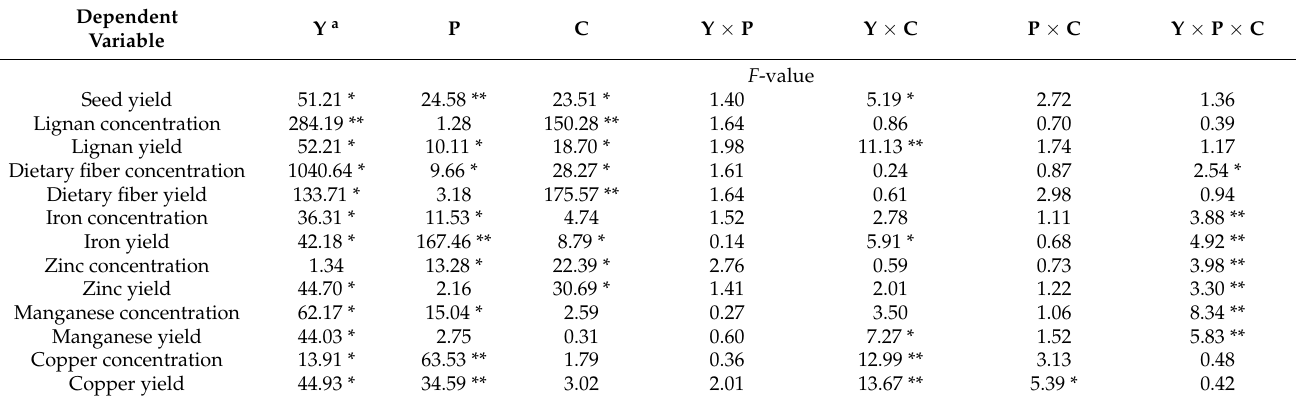
Table 2. Analysis of variance results for the dependent